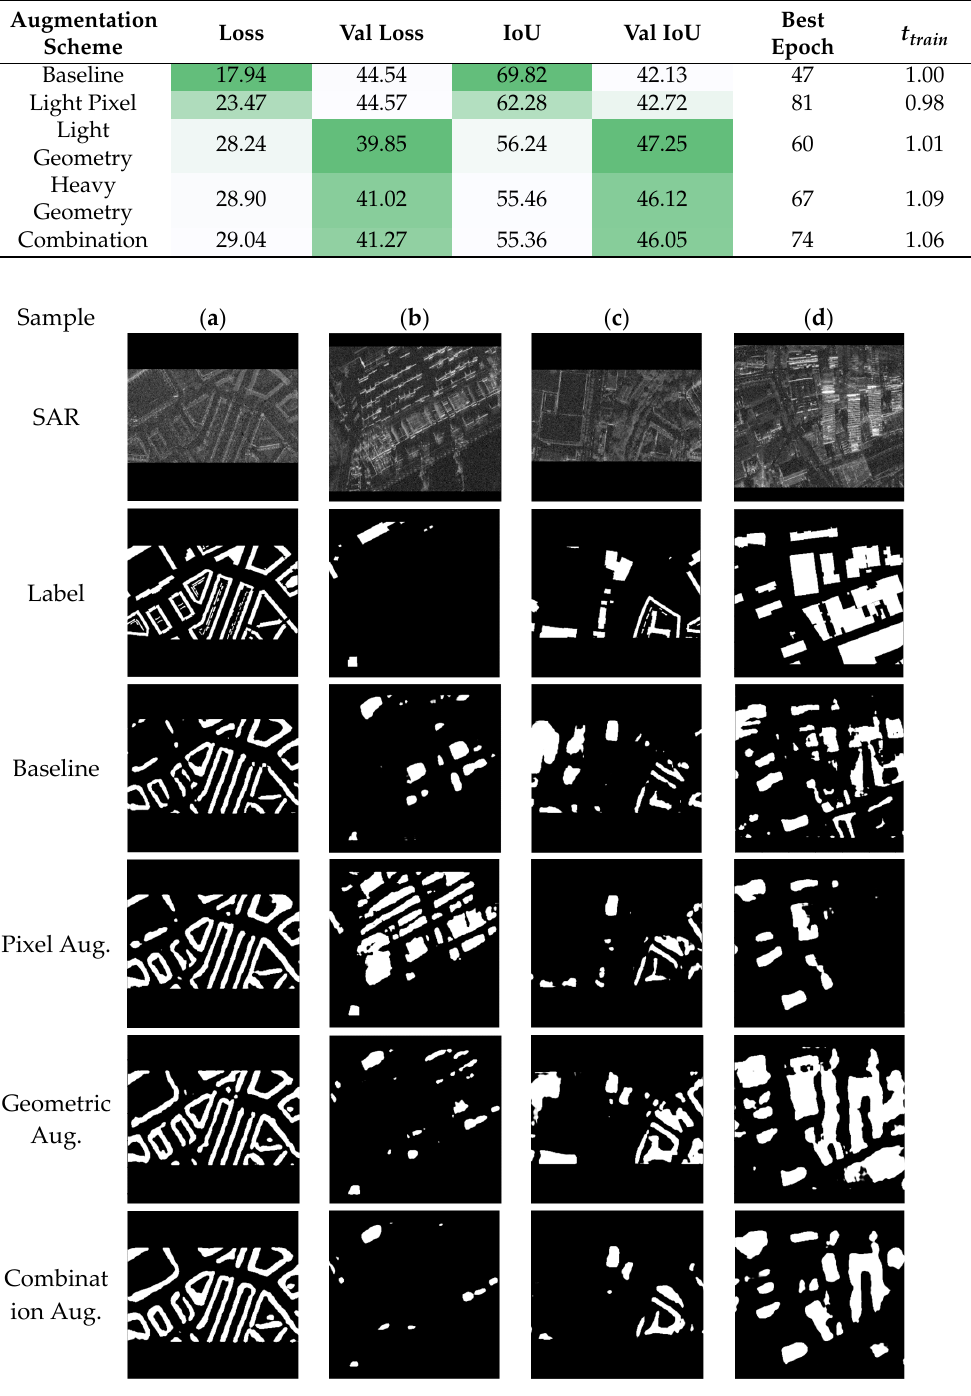
Figure 15. Comparison of predictions from the trained models of different scene objects: ( a ) medium-height residential buildings, ( b ) containers in a shipping port, ( c ) outdoor sports field, and ( d ) high-rise buildings.